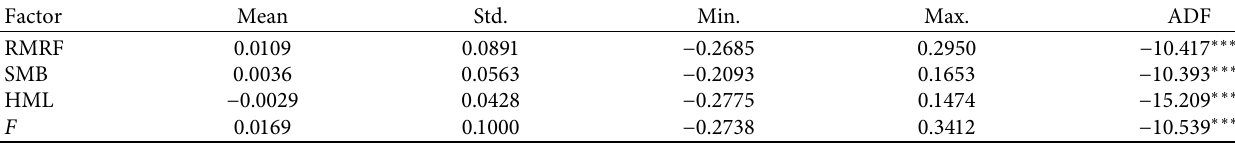
Table 1: Descriptive statistical results of four